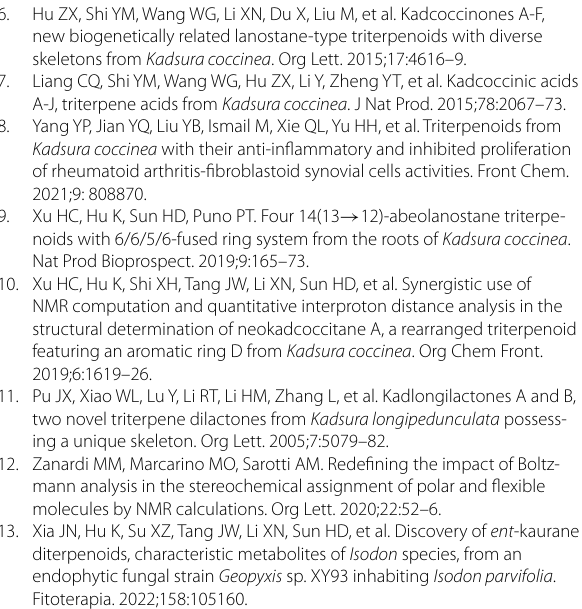
Table 1. For their 13 C NMR data, see Table